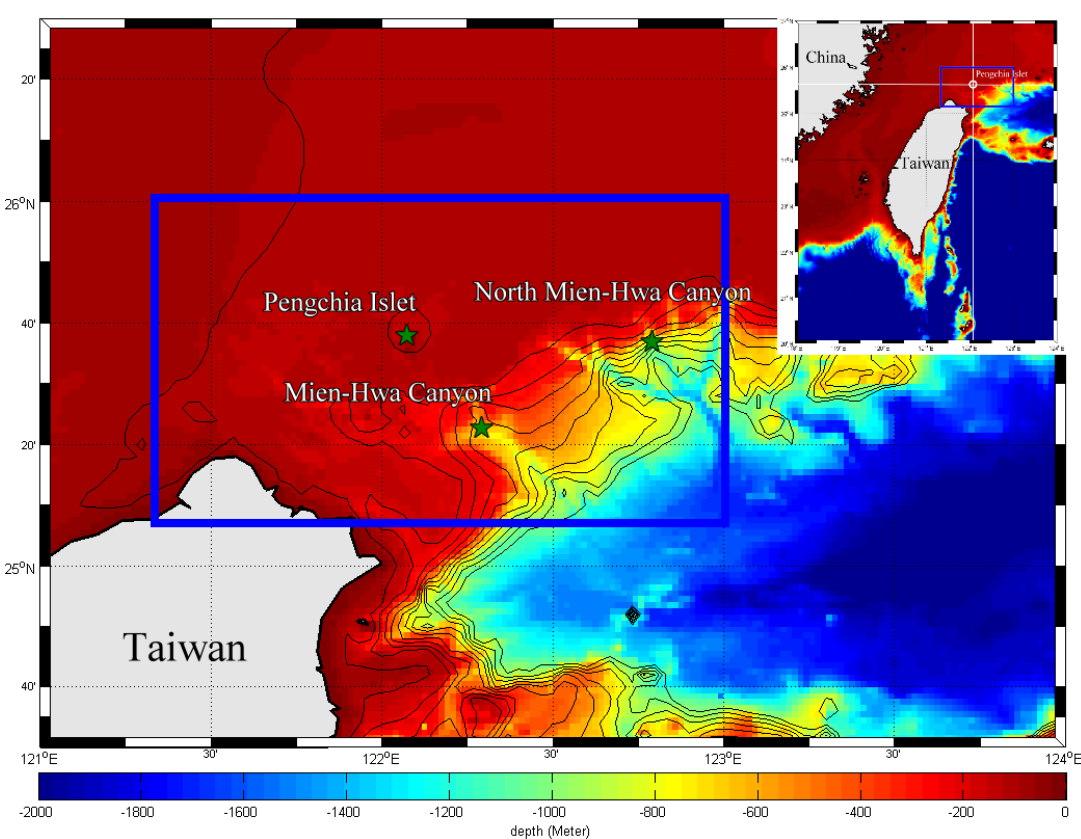
Figure 2. The bathymetry northeast off Taiwan. The inside of blue rectangle is the study area with bathymetry in